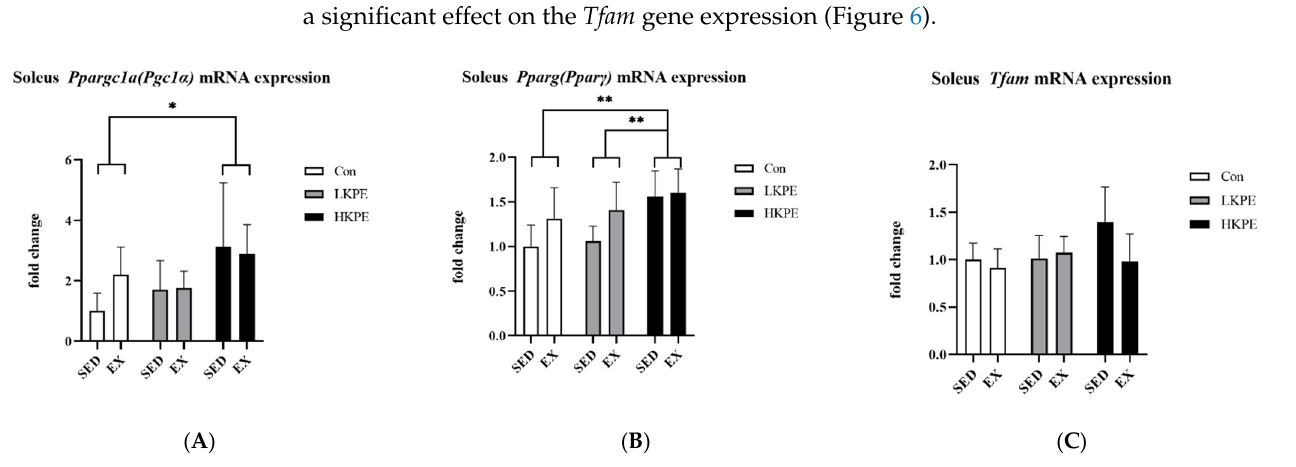
Figure 6. mRNA expression of ( A ) Ppargc1a (Pgc-1 α ) , ( B ) Ppar γ , and ( C ) Tfam in soleus muscle immediately after exhaustion. Ppar γ , peroxisome proliferator-activated receptor gamma; Ppargc1a (Pgc-1 α ) , peroxisome proliferator-activated receptor gamma coactivator 1-alpha; Tfam , mitochon- drial transcription factor A; SED, sedentary; EX, exercise; Con, control; KPE, Kaempferia parviflora administration; ns, no significance observed; * p < 0.05, ** p < 0.01.